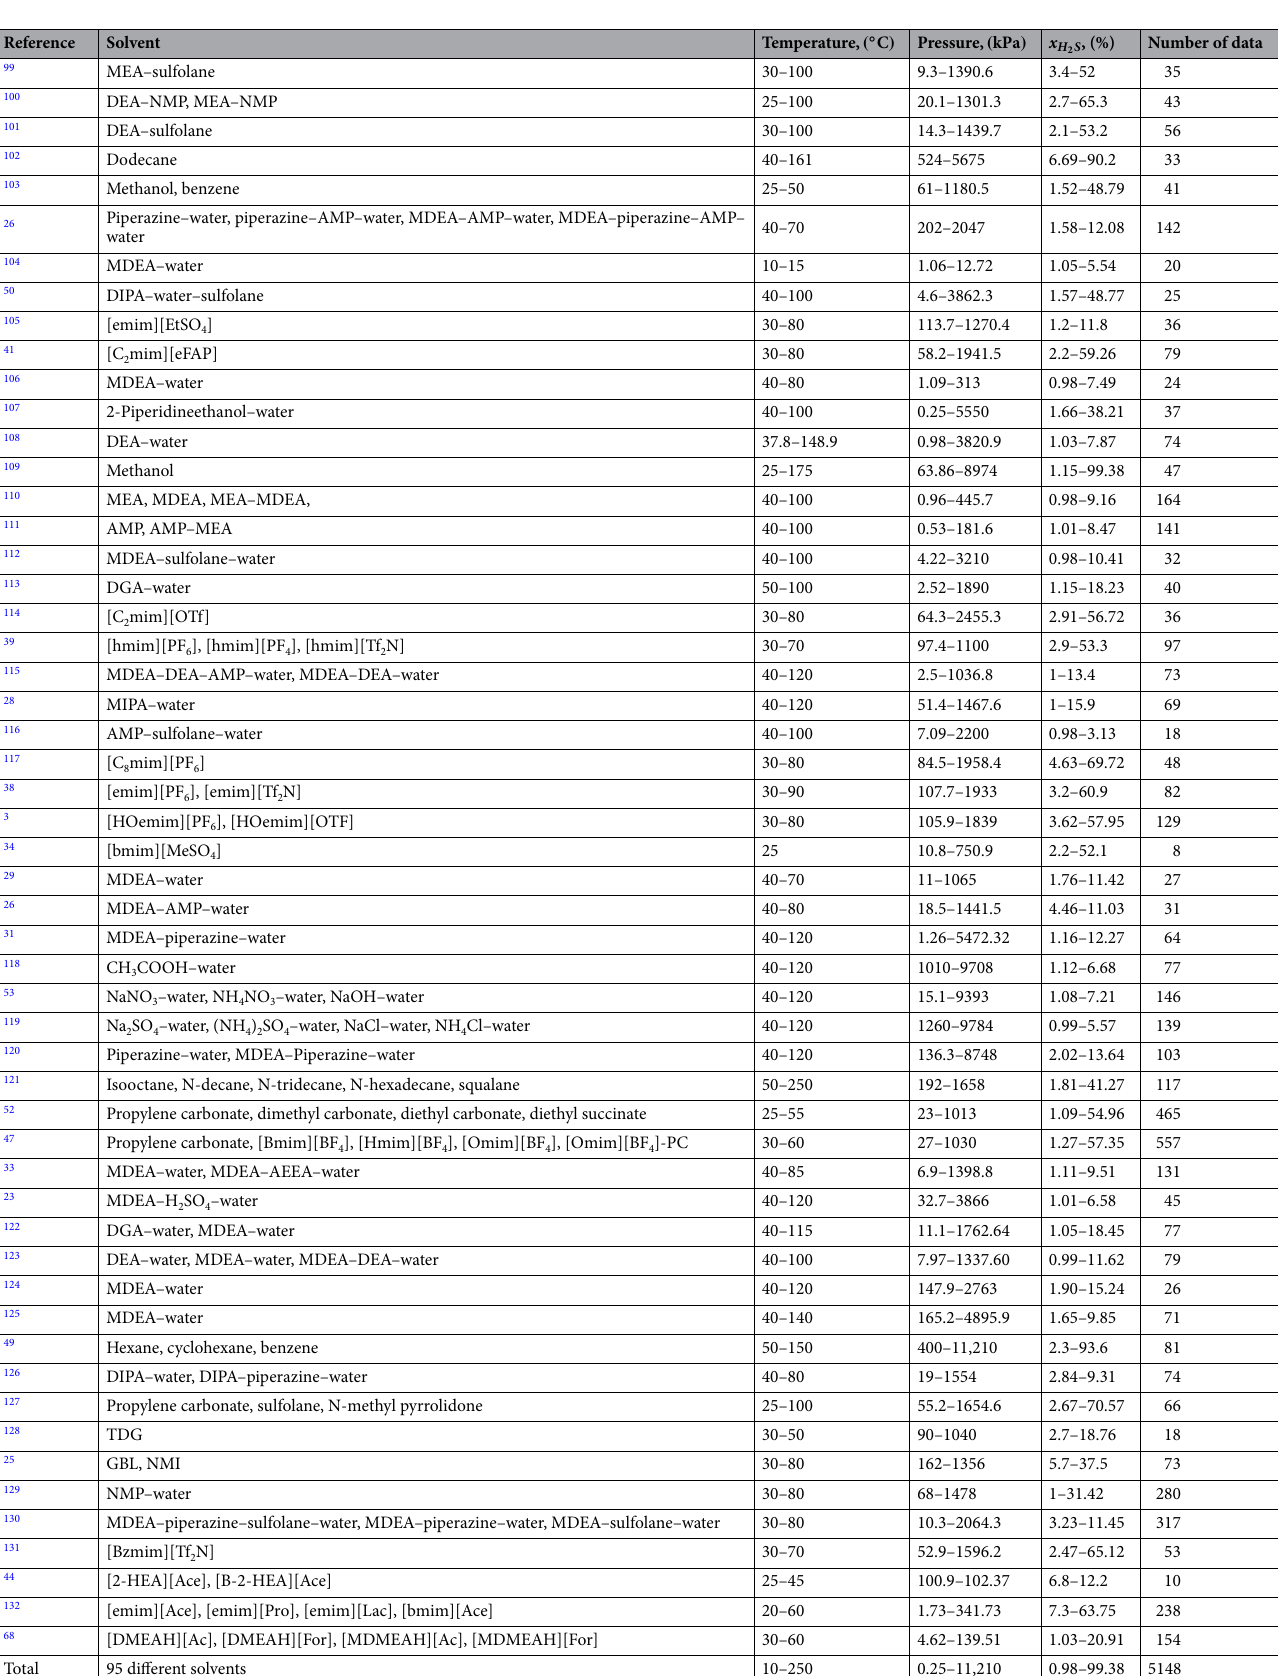
Table 2. Operating ranges of analyzed sources for H 2 S solubility in